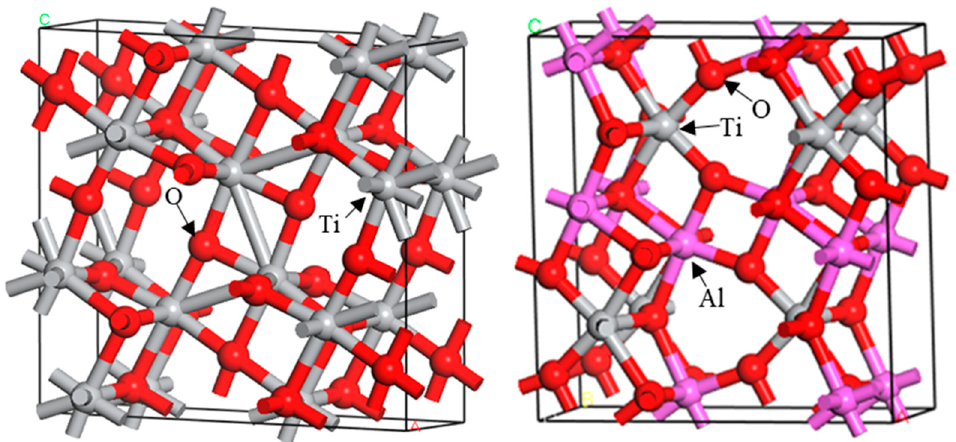
Figure 1. Crystal cell models of Ti 3 O 5 [23] and Al 2 TiO 5 .